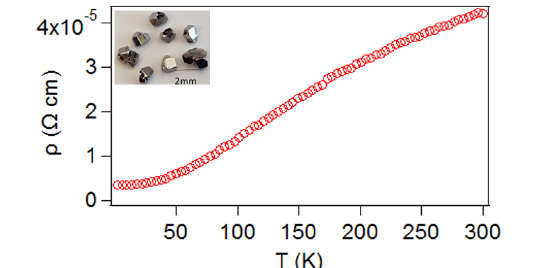
Figure 4. Resistivity vs. temperature of an unoriented crystal of TaP. Single crystals of TaP are shown in the inset.